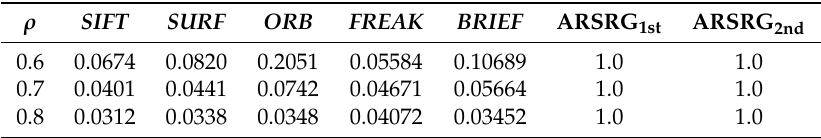
Table 3. Quantitative comparison using the precision measure, among SIFT [8], SURF [29], ORB [30],